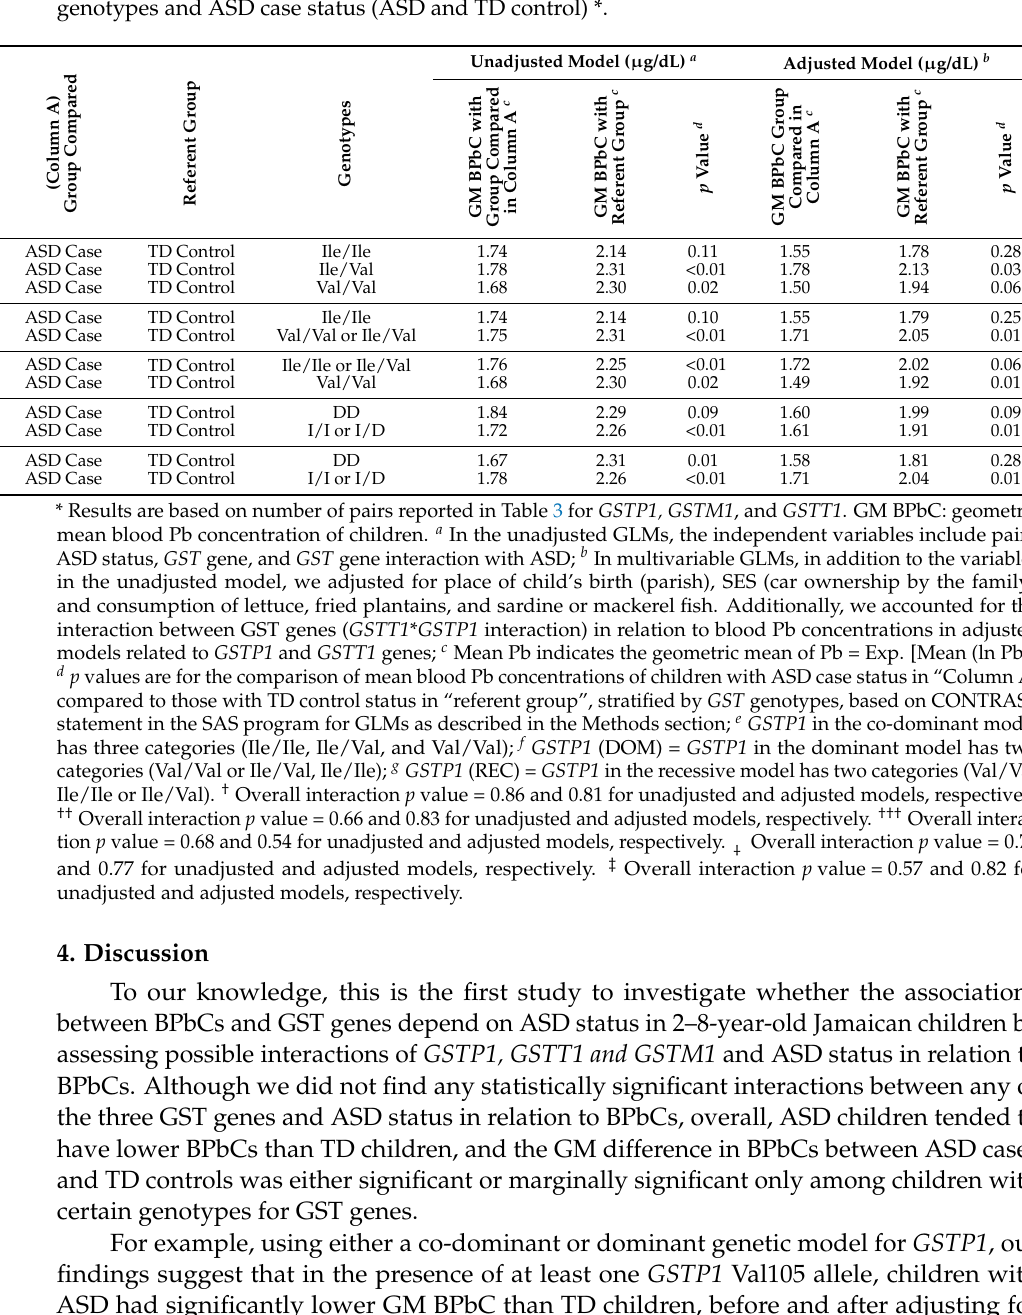
Table 5. Unadjusted and adjusted geometric mean blood Pb concentration (GM BPbC) by ASD status (ASD and TD control) based on general linear models (GLMs) that include interaction between GST genotypes and ASD case status (ASD and TD control)